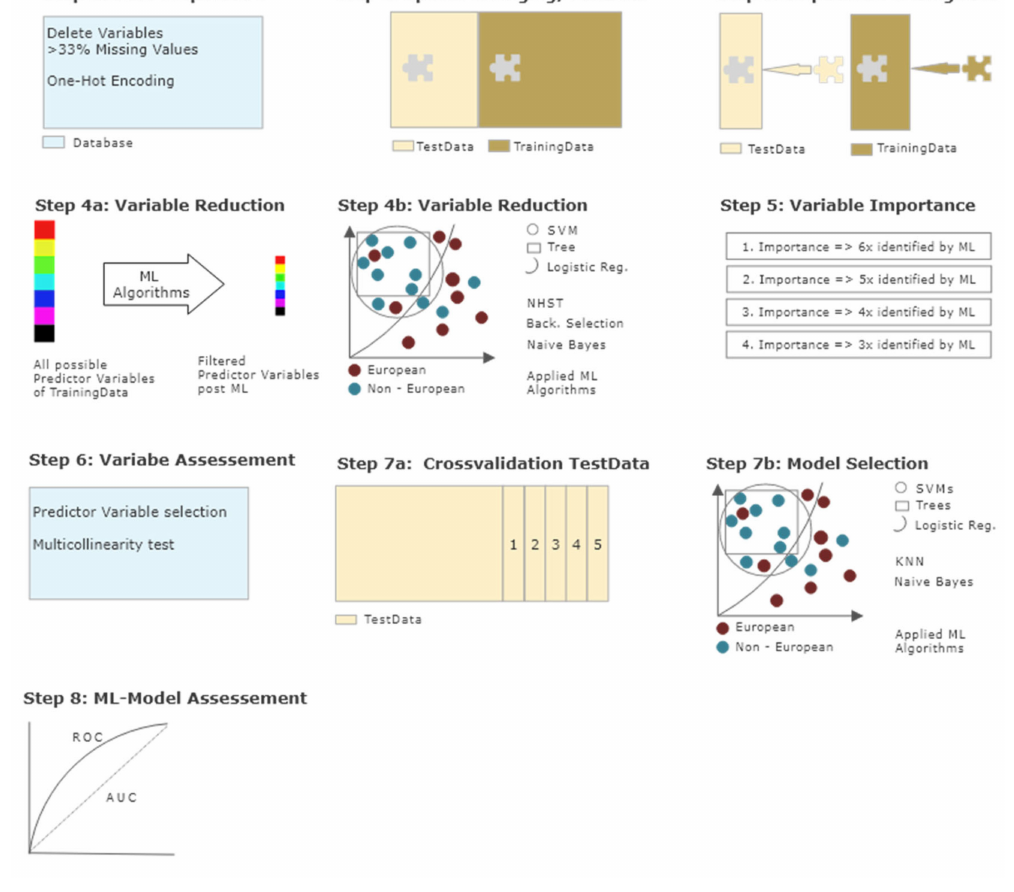
Figure 1. Data processing and statistical analysis. Step 1 —Data preparation: Variables with more than 33% missing values eliminated; multiple categorical variables one-hot encoded; continuous variables not manipulated. Step 2 —Data split: Split in training dataset with 70% of cases and test dataset with 30% of cases. Step 3 —Imputation: Training and test dataset separately imputed via multivariate imputation by chained equations (MICE). Step 4a , b —Variable reduction: Identification of most influential variables in training dataset via di ff erent machine learning algorithms. Step 5 —Variable importance: Variables ranked in order of importance, based on the number of times identified as most important by machine learning algorithms. Step 6 —Variable assessment: Check for multicollinearity and selection of predictor variables identified at least 3x by algorithms. Step 7a , b —Model selection: Calculation and selection of best machine learning algorithm with identified predictor variables on test dataset embedded in 5-fold cross-validation. Step 8 —Model assessment: Accuracy, area under the curve (AUC), sensitivity, specificity, positive predictive value (PPV), negative predictive value (NPV), extraction of best